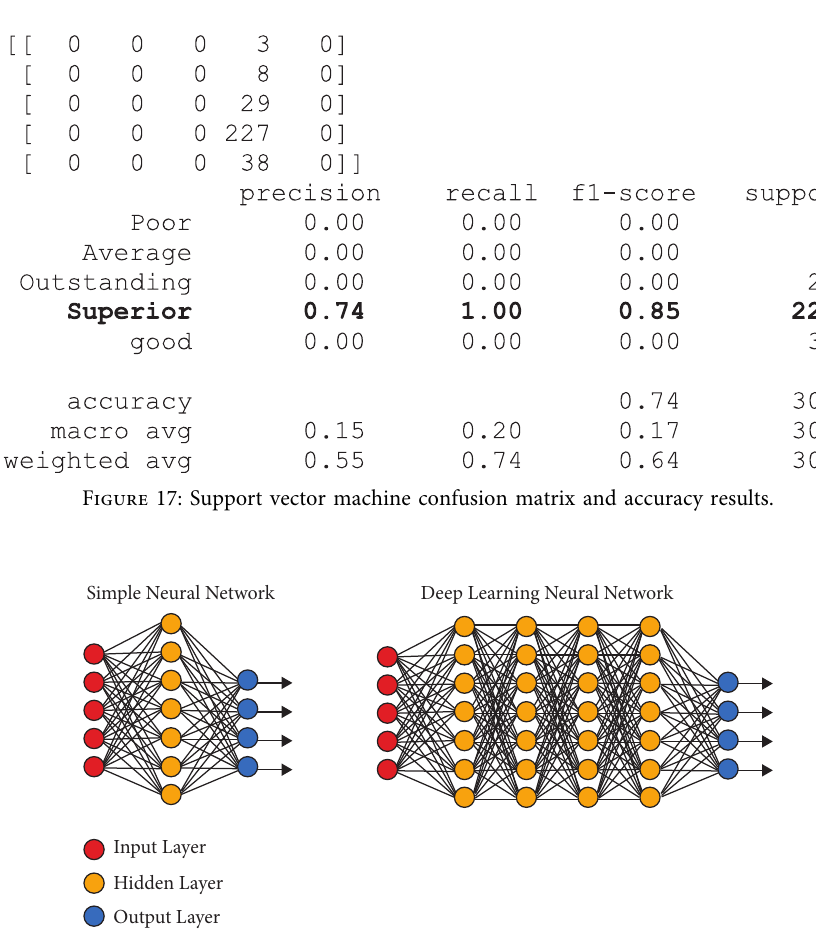
Figure 18: Deep learning: https://towardsdatascience.com/mnist-vs-mnist-how-i-was-able-to-speed-up-my-deep-learning-11c0787e6935.